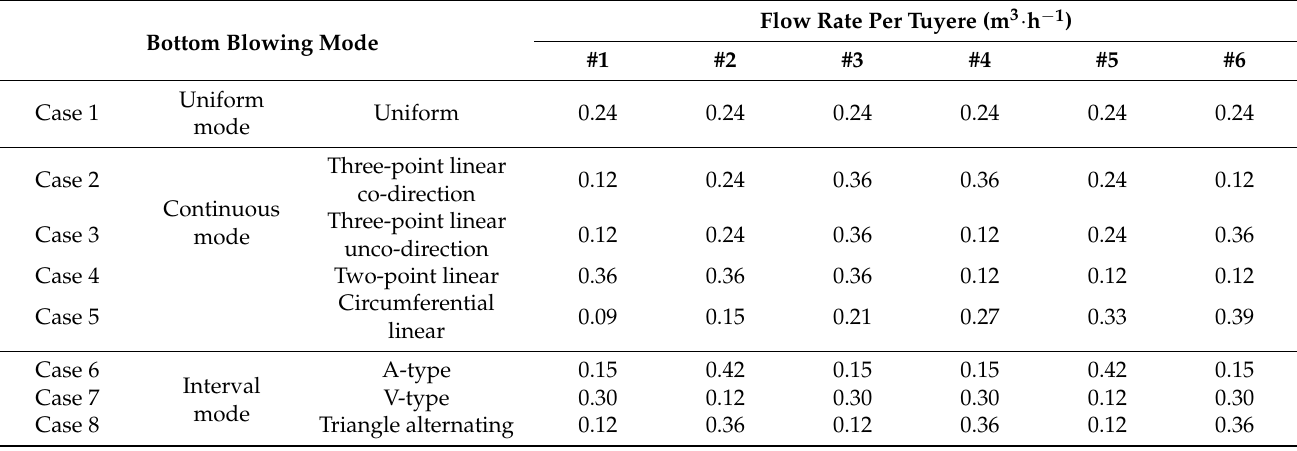
Table 2. Bottom blowing mode conditions of the eight